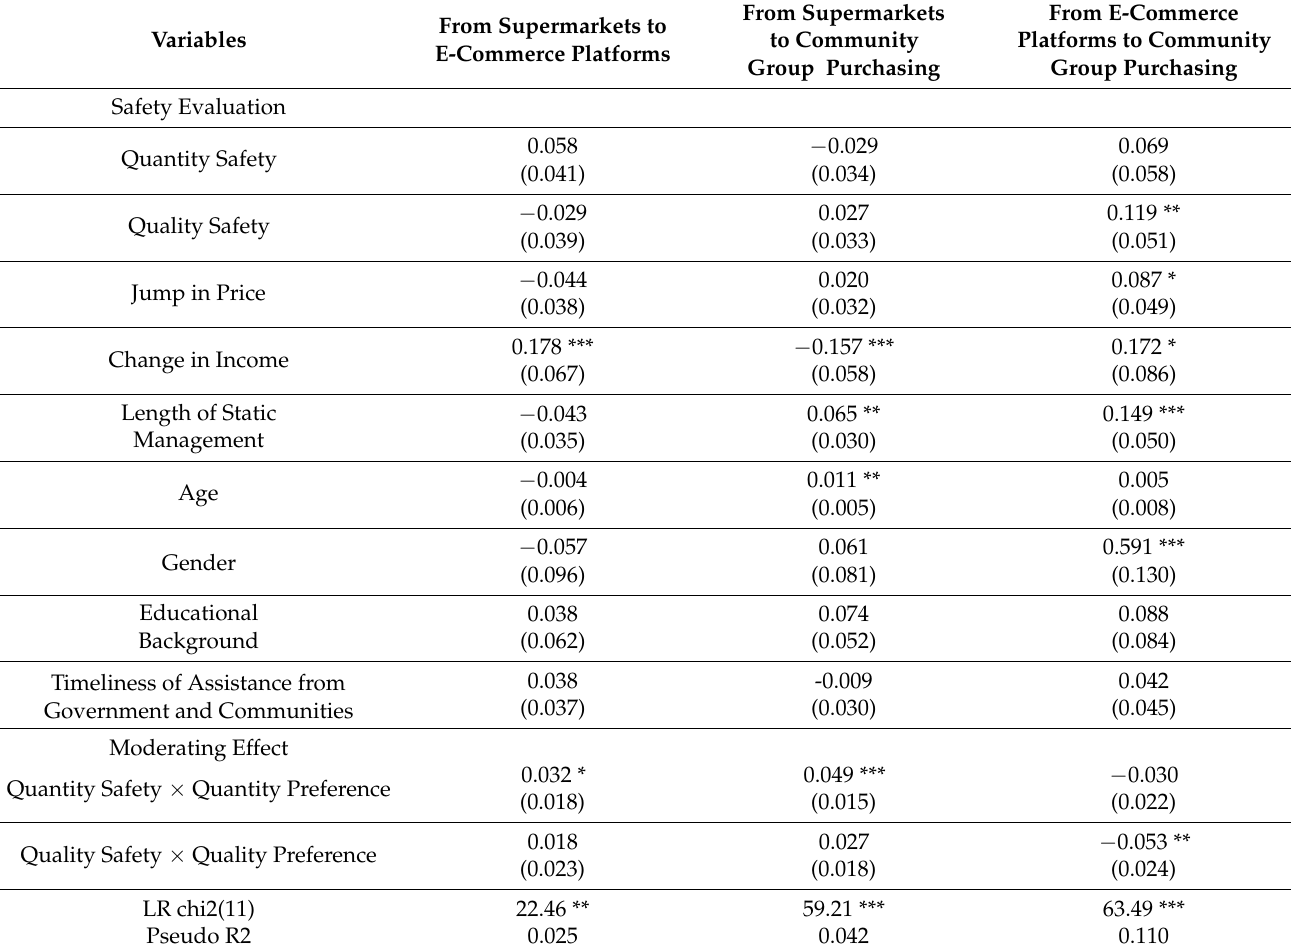
Table 4. Probit model regression results for three specific transformations of shopping